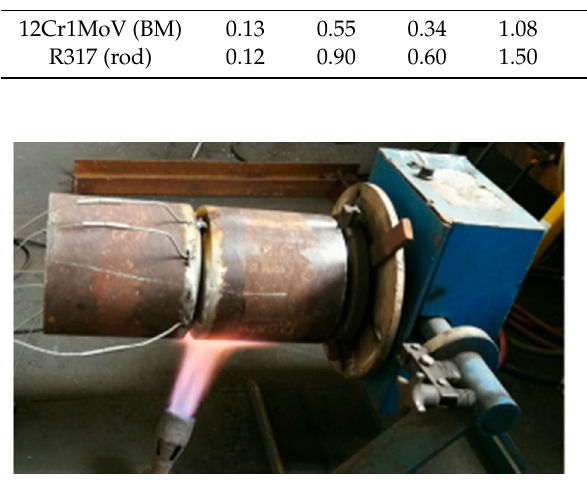
Figure 2. Pre-heat treatment of 12Cr1MoV pipe welded joint.